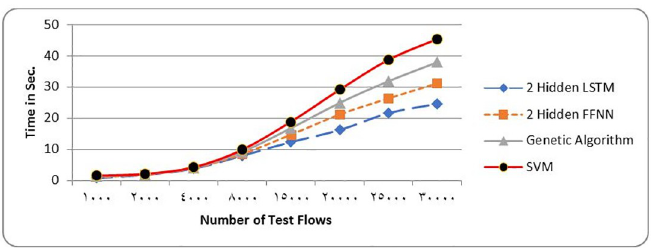
Fig 8. NSL-KDD Time comparison among different classification